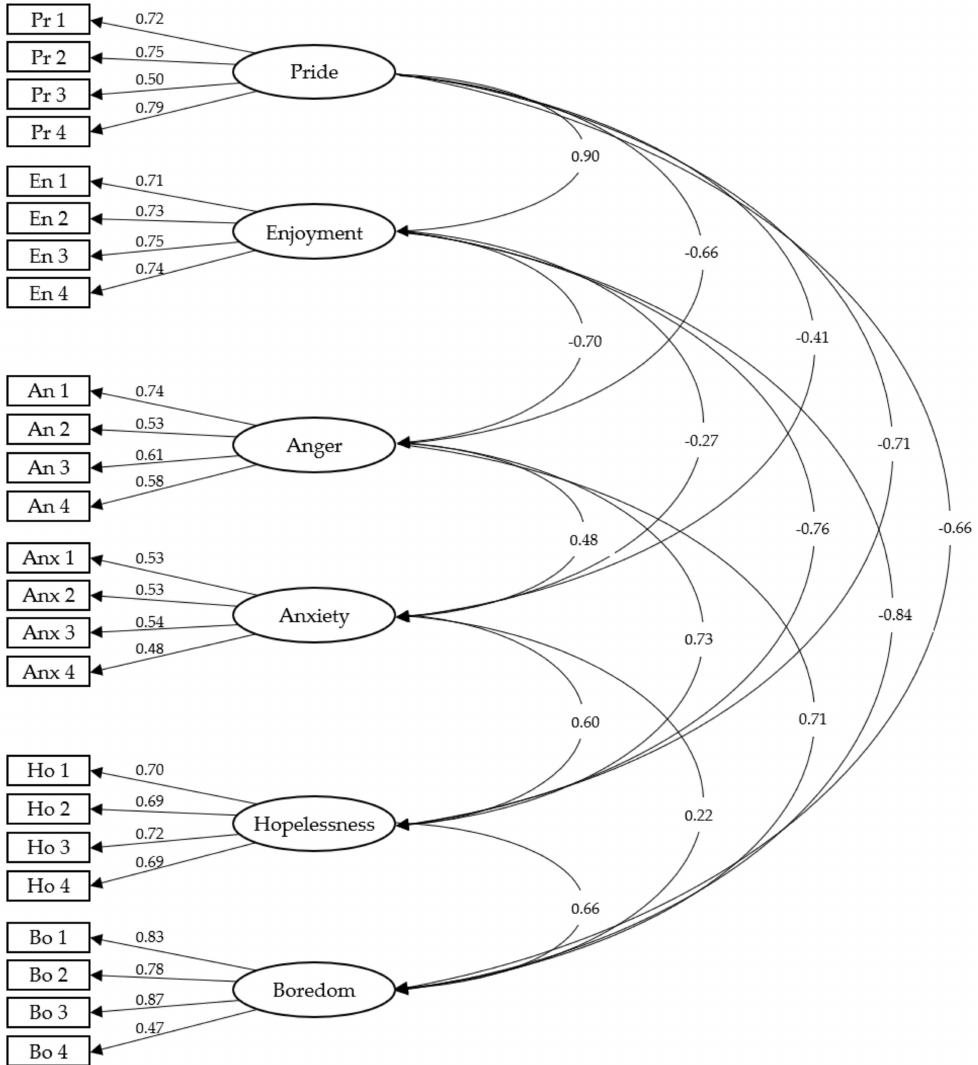
Figure 1. Confirmatory factor analysis of the Achievement Emotions Questionnaire for Physical Education (AEQ-PE). Pr, pride; En, enjoyment; An, anger; Anx, anxiety; Ho, hopelessness; Bo, boredom. The ellipses represent the factors and the rectangles represent the specific